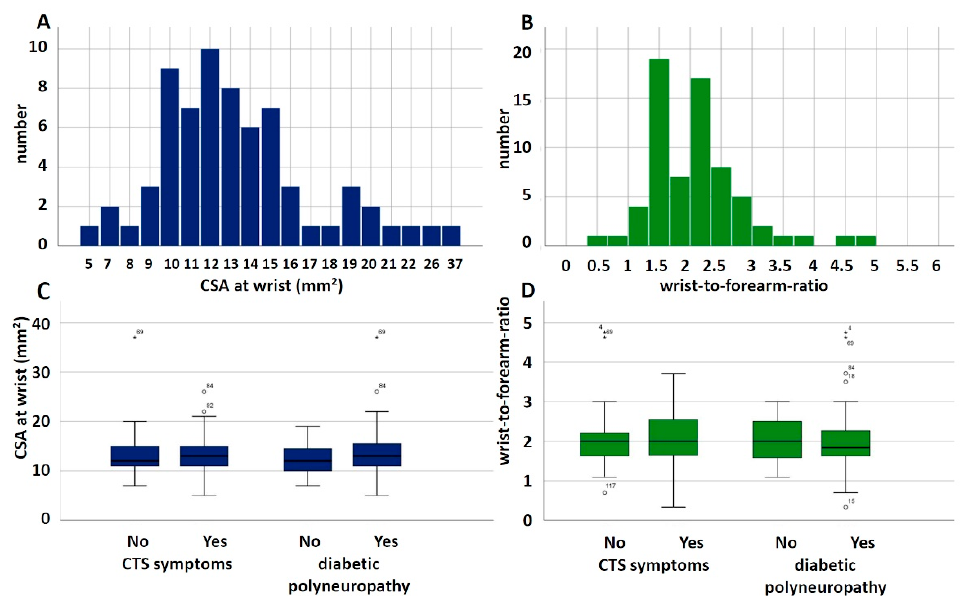
Figure 3. Peripheral nerve ultrasound measurements of the median nerve at the wrist. ( A ) Histogram of the CSA at the wrist. ( B ) Histogram of the wrist-to-forearm-ratio. ( C ) Box plots of median nerve CSA at the wrist in patients with and without CTS symptoms and patients with and without diabetic polyneuropathy. ( D ) Box plots of wrist-to-forearm-ratio in patients with and without CTS symptoms and patients with and without diabetic polyneuropathy.